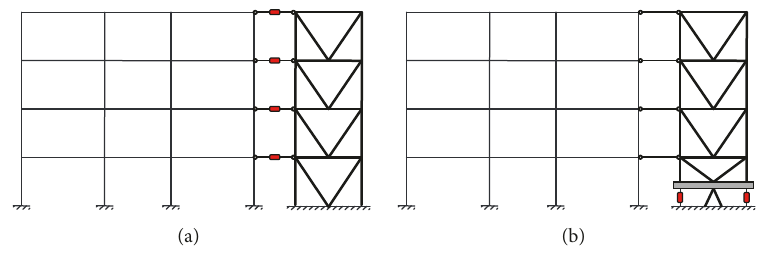
Figure 1: Coupling of the existing frame with (a) external fixed-based (FB) structure; (b) rocking-base (RB)